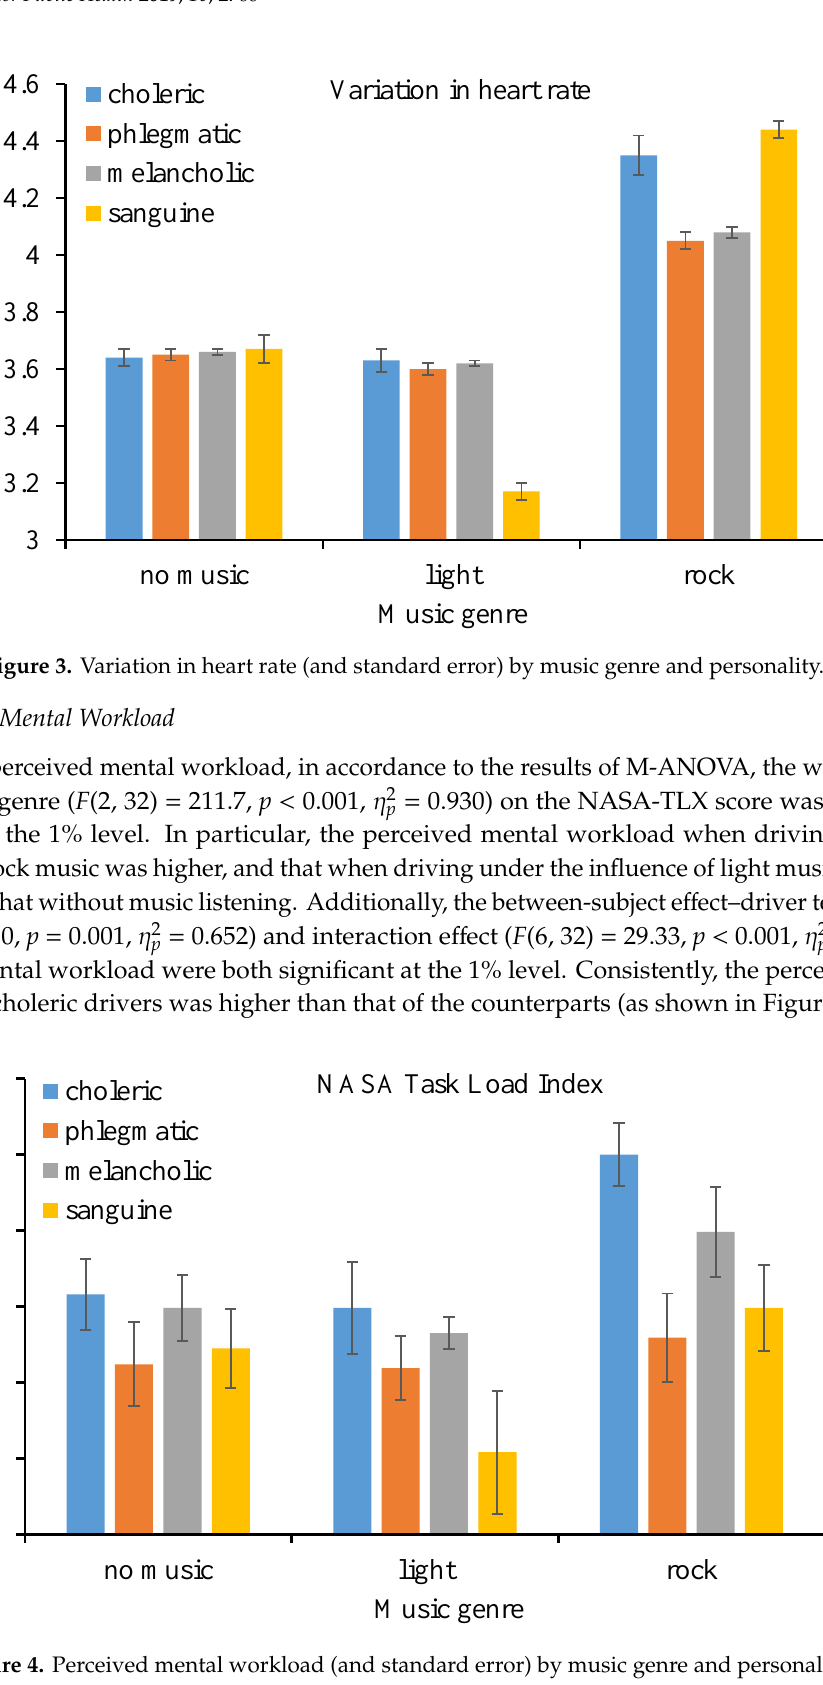
Figure 4. Perceived mental workload (and standard error) by music genre and personality.